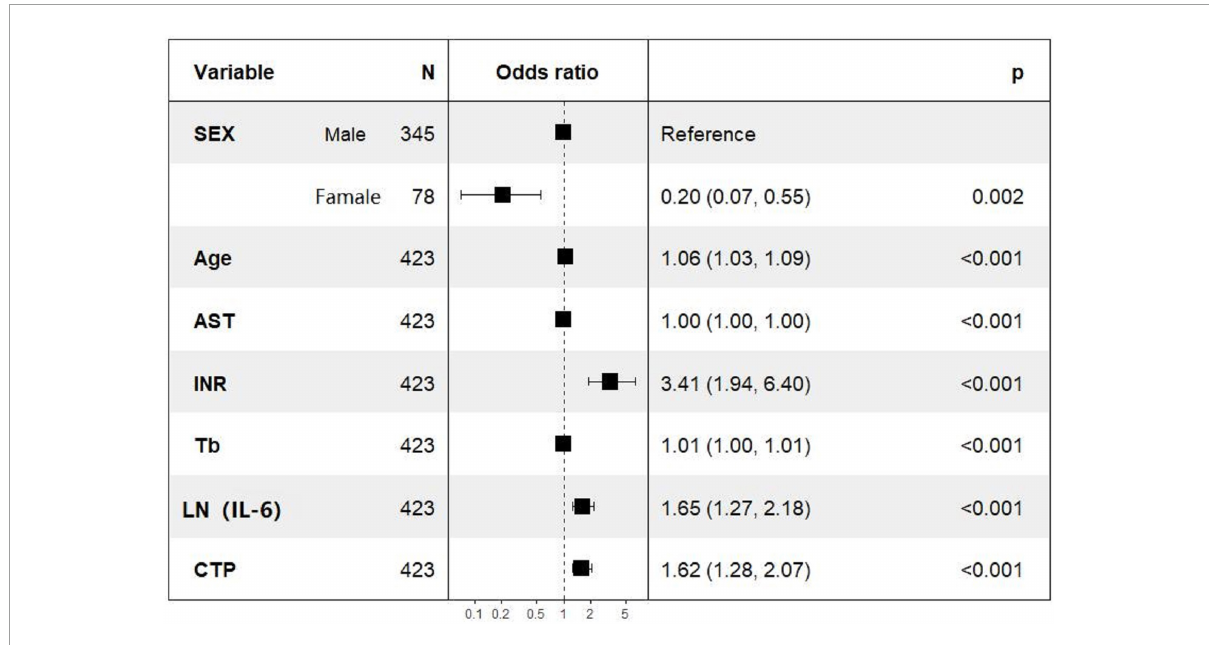
FIGURE2 The forest map represents the result of multivariate logistic regression.